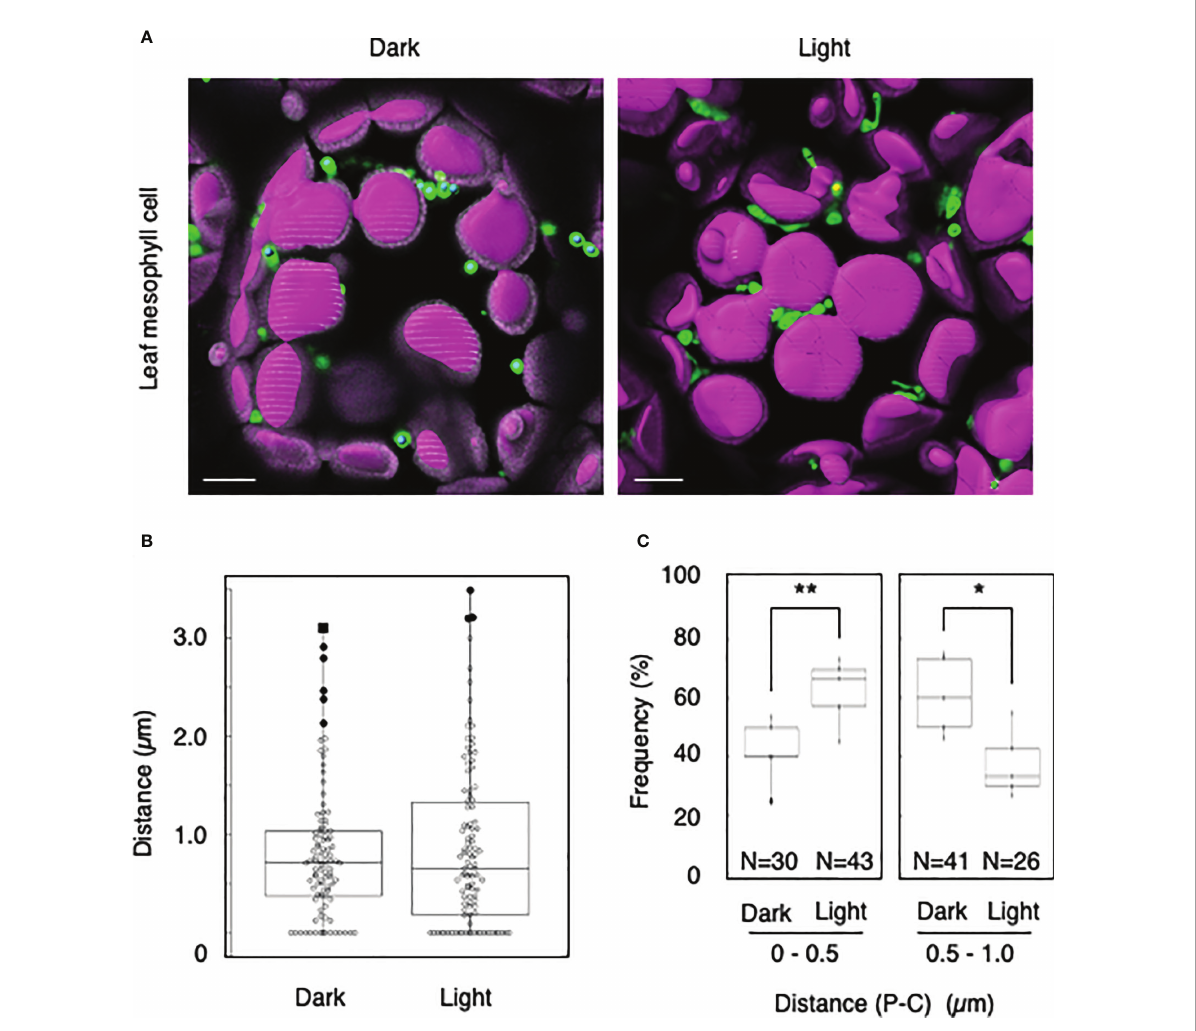
FIGURE 1 Measurement of the distances between chloroplasts and peroxisomes in leaf mesophyll cells. (A) Representative images of chloroplasts (magenta) and peroxisomes (green) in leaf mesophyll cells in the dark and light. Bars, 10 µm. (B) Box plots of the distances between peroxisomes and chloroplasts in the dark and light from fi ve cells. The average distance was 0.81 ± 0.68 µm (n = 99) in the dark and 0.51 ± 0.46 (n = 106) in the light. The median was 0.72 µm in the dark and 0.657 µm in the light. (C) Frequency of the distances between peroxisomes and chloroplasts in the dark and light. The frequency of distances of 0 – 0.5 µm was 41.8 ± 11.2% (n = 30) in the dark and 62.4 ± 11.5% (n = 43) in the light. The frequency of distances of 0.5 – 1.0 µm was 60.9 ± 13.1% (n = 41) in the dark and 37.6 ± 11.5% (n = 26) in the light in (B) . * P < 0.01, ** P < 0.01, Student ’ s t